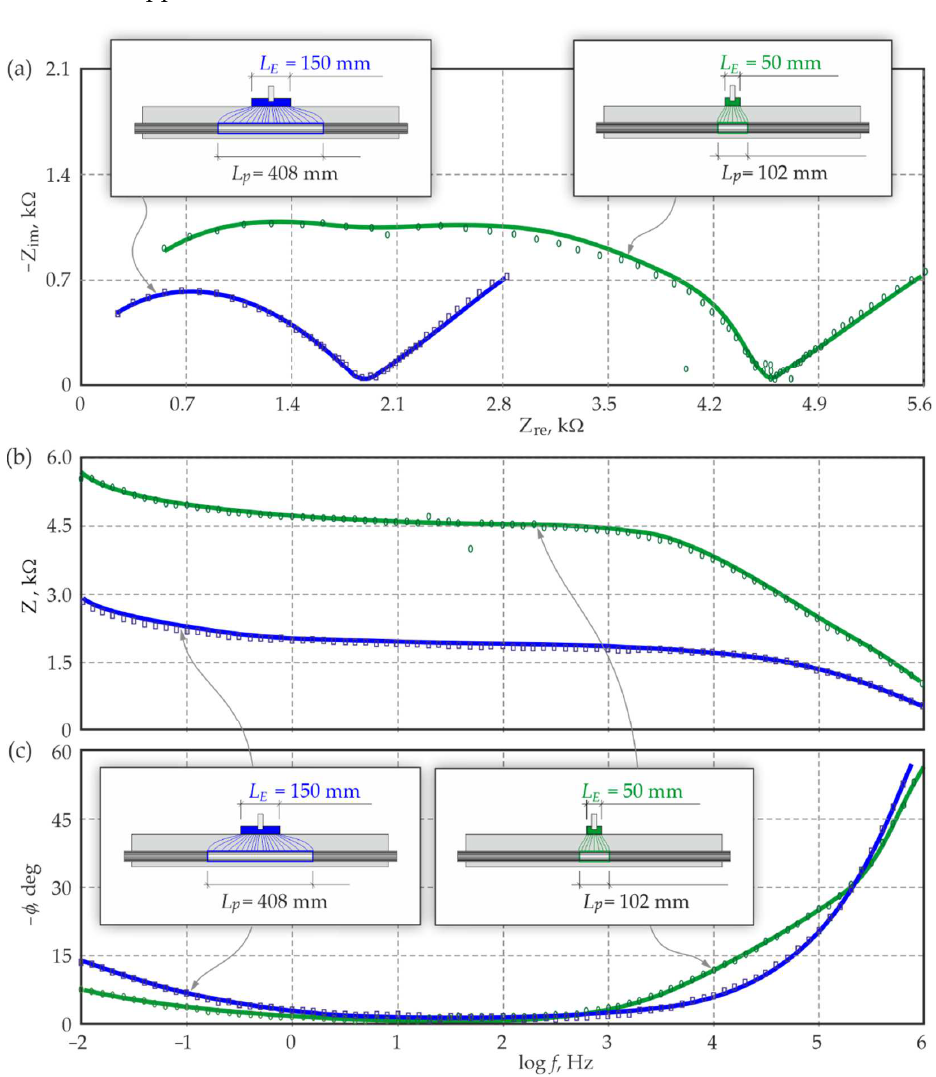
Figure 9. Comparative presentation of matching the model spectra (solid lines) to experimental spectra (points) for two lengths L E of counter electrodes, according to the original iterative method for determining the polarized area of reinforcement during the EIS tests on reinforced concrete: ( a ) the Nyquist plot, ( b ) the Bode Z (log f ) plot, ( c ) the Bode j (log f ) plot.